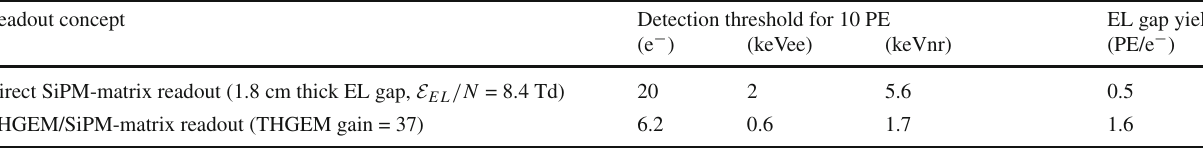
deposited energy in liquid Ar for electron (keVee) and nuclear (keVnr) recoils, at a drift field in liquid Ar of 0.24 kV/cm. Also shown are the EL gap yields